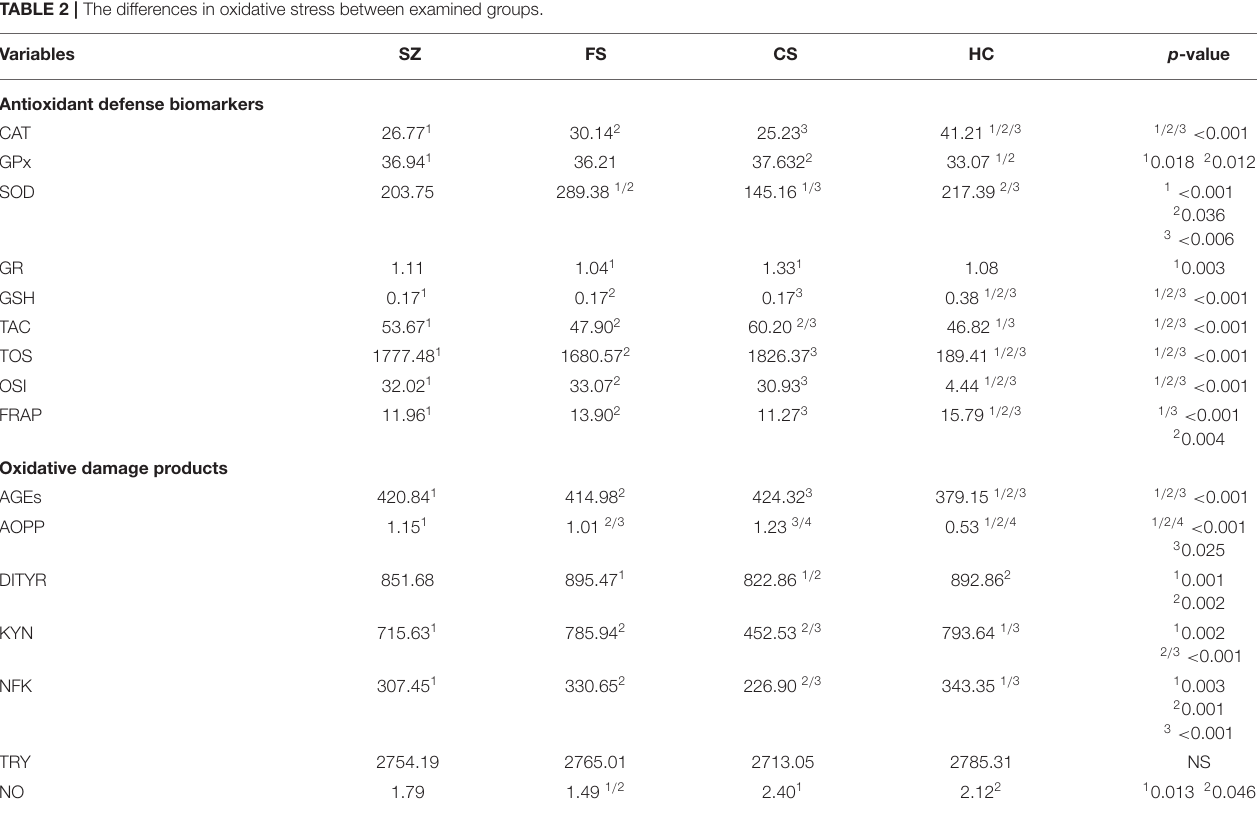
TABLE 2 | The differences in oxidative stress between examined groups.